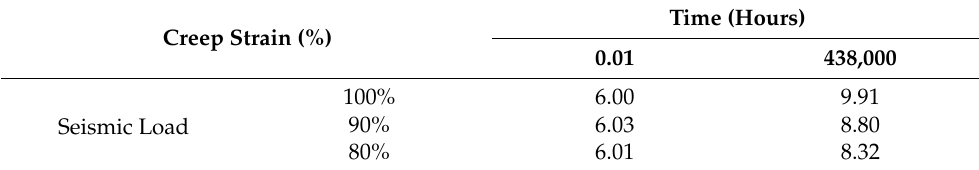
Table 11. Creep strain of LCP woven geotextile during creep test by 50% of UTS at initial and critical times.